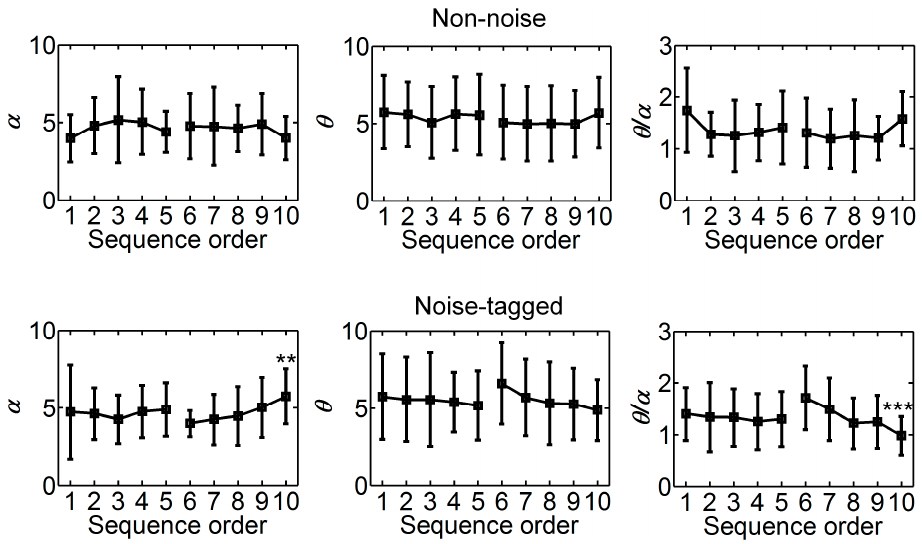
Figure 5. Comparison of mental load indices between on-task stimulation sequences in both non-noise and noise-tagged BCI tasks across participants. The mean values and SD of α and θ powers and θ / α ratio were calculated from 10 consecutive stimulation sequences with the same order across twelve participants. All statistics were assessed by one-way ANOVA, ** p < 0.01 between five consecutive stimulation sequences in either the first or the second runs of two sequential runs, *** p < 0.001 between five consecutive sequences.